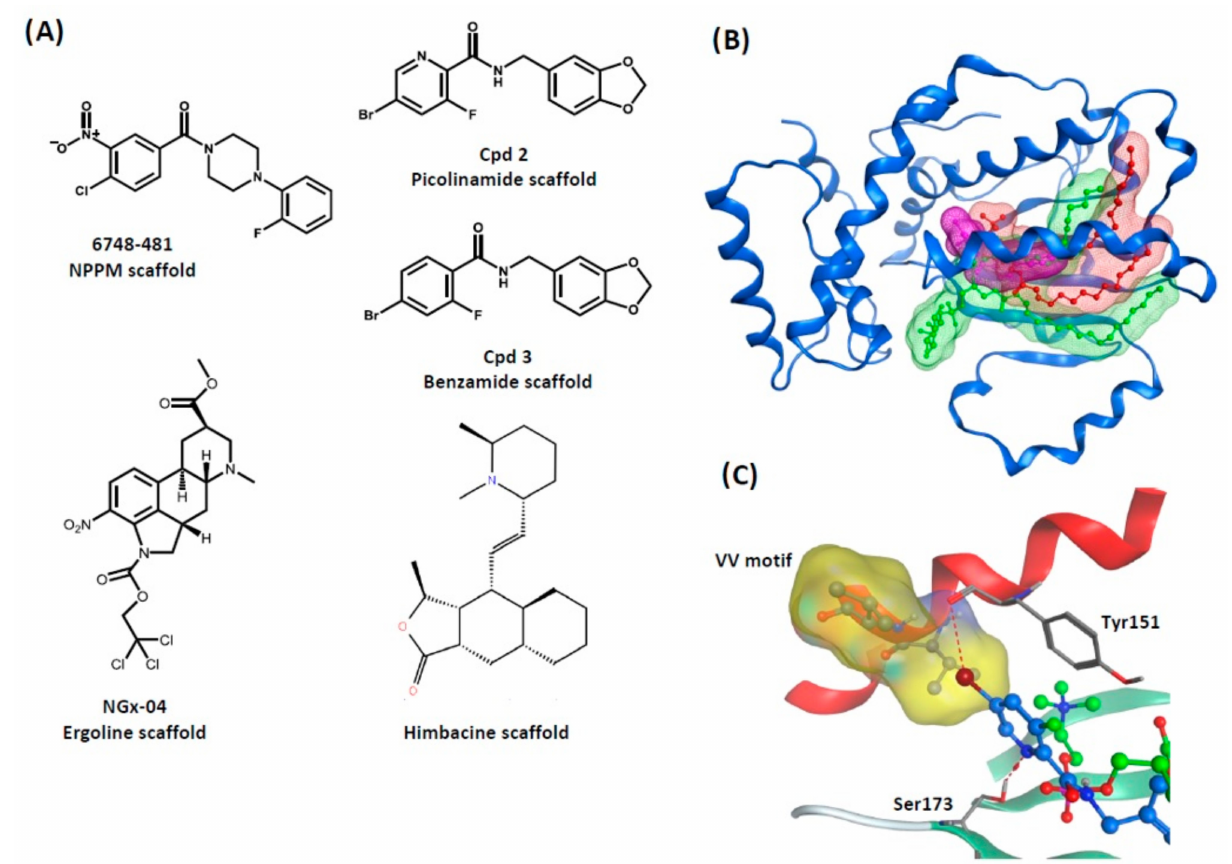
Figure 6. Sec14 small molecule inhibitors. ( A ) Validated small molecule inhibitors of yeast Sec14 are shown. All directly inhibit Sec14 activity in vitro and all but himbacine show fungicidal activities against S. cerevisiae in vivo. The picolinamide and benzamide derived inhibitors are termed compounds 2 and 3, respectively, as per the nomenclature used to describe them in [141]. ( B ) Binding pose of picolinamide-based compound 2 (magenta) as determined by X-ray crystallography confirms the Sec14-active small molecule inhibitors occupy the acyl chain binding regions of PtdIns (green overlay) and PtdCho (red overlay) as well the the PtdCho headgroup coordinating region. The Sec14 lipid binding domain is rendered as blue ribbon. ( C ) a magnified view of an overlay of the picolinamide-based inhibitor compound 2 (blue, ball&stick rendering) and PtdCho (green, ball&stick) with respect to VV motif and other PtdCho headgroup-coordinating residues within the Sec14 lipid-binding pocket. The VV-motif is shown in yellow translucent surface render. The halogen bond between the bromine moiety of compound 2 and the backbone keto group of residue Tyr151 is